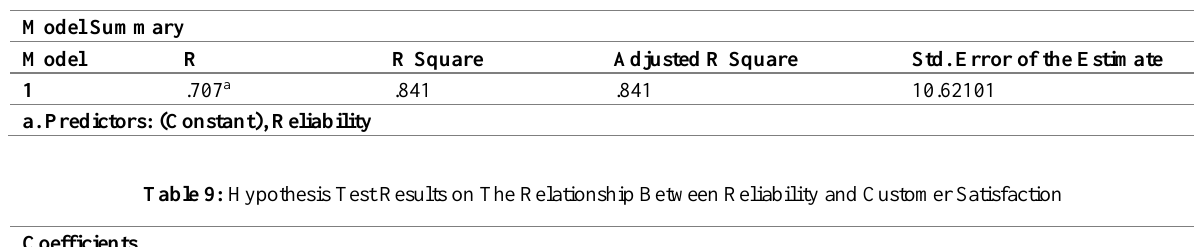
Table 8: Regression Analysis Table for The Relationship Between Reliability and Customer Satisfaction